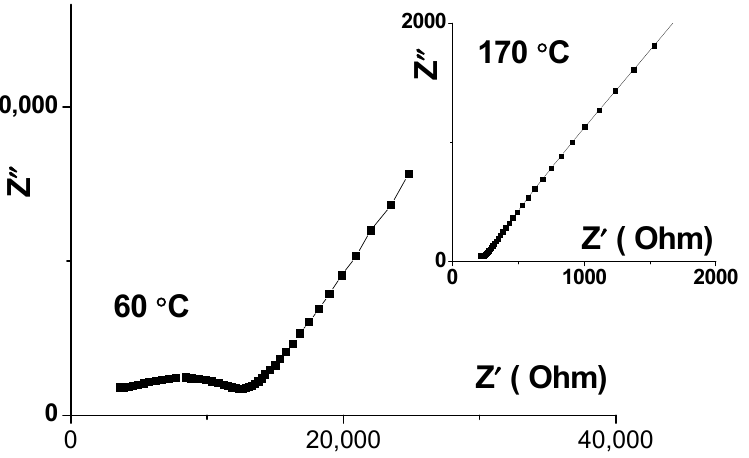
Figure 5. Impedance plots for Pt | Li 3.8 Ge 0.9 S 0.1 O 4 | Pt electrochemical cell at 60 and 170 ◦ C.